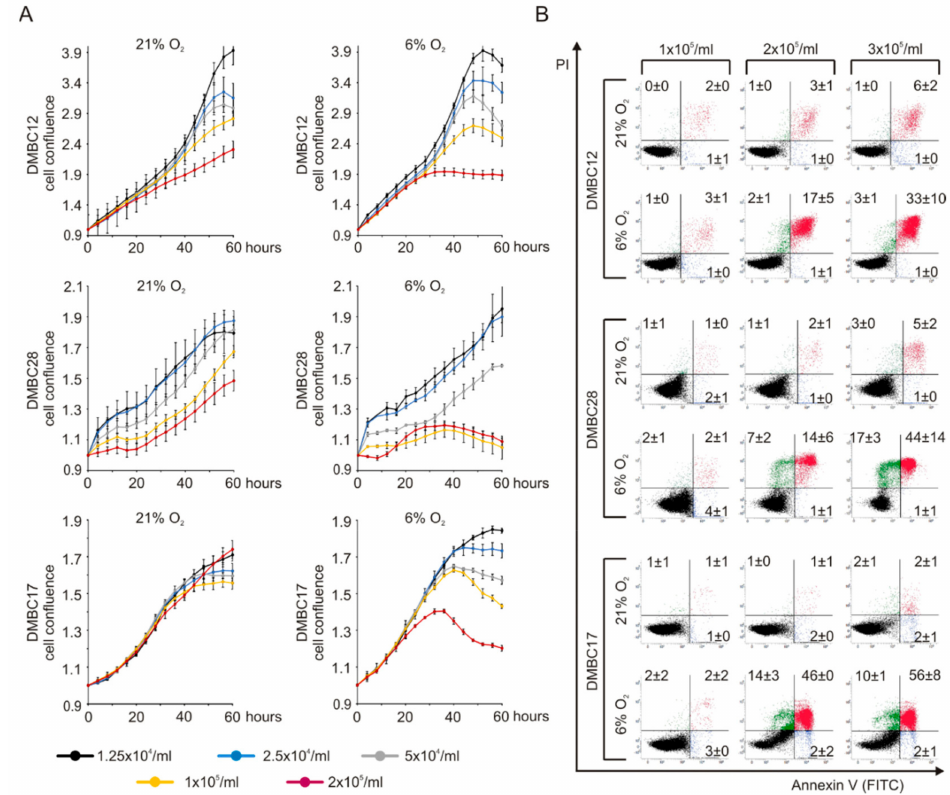
Figure 1. Proliferation and survival of melanoma cells cultured in 6% O 2 greatly depend on melanoma cell density. ( A ) Proliferation time-courses of melanoma cells of varying seeding densities in 21% O 2 and 6% O 2 . Cell proliferation was measured as changes in the occupied area over time using IncuCyte, and shown as fold-change relative to the confluence at time T 0 . ( B ) Representative dot plots of Annexin V / propidium iodine (PI) stained cells after 72 h in culture, showing early apoptotic (blue), late apoptotic (red), and necrotic (green) cells. Numbers in each quadrant are percentages of cells (mean values of three biological replicates ± SD). DMBC, melanoma cell populations obtained at the Department of Molecular Biology of Cancer from surgical